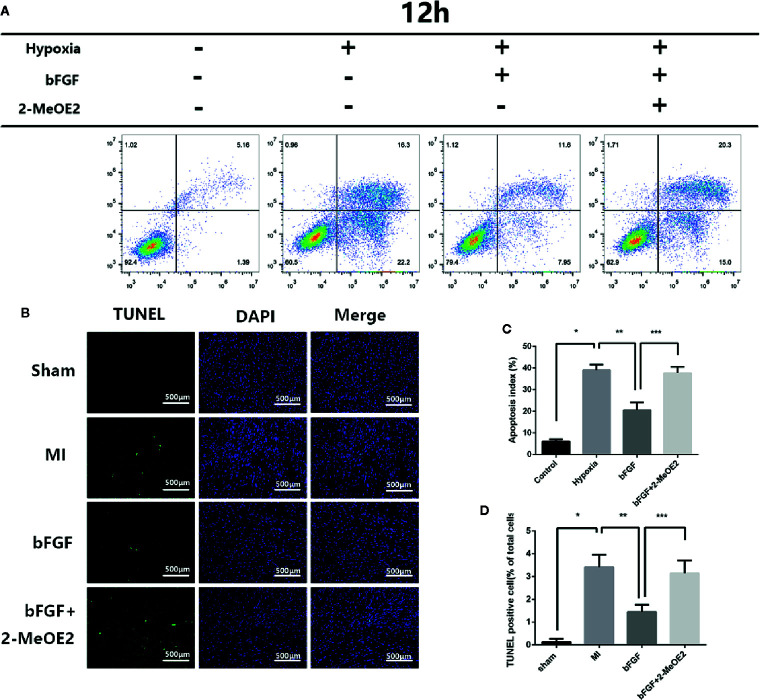
Resistance to apoptosis in infarcted areas and MMECs after treatment with bFGF. (A) Apoptosis was evaluated by flow cytometry. Pretreated cells were collected, stained with Annexin-V and PI, and analyzed by FCM (flow cytometry). (C) Apoptotic index values of the different groups. *
P<0.05 vs. NC group; **
P<0.05 vs. hypoxia group; ***
P<0.05 vs. hypoxia + bFGF group. ;NS, non significance vs. bFGF+2-MeOE2 group. (B) Evaluation of the apoptotic rate by TUNEL staining. Representative images of apoptotic cells are shown. The apoptotic cells were detected by TUNEL staining, and the nuclei were detected by DAPI. Scale bar: 20 μm. (D) Proportions of TUNEL-positive cells (% of total cells). *
P<0.05 vs. MI group; **
P<0.05 vs. bFGF group; ***
P<0.05 vs. bFGF + 2-MeOE2 group (n=3 each group).